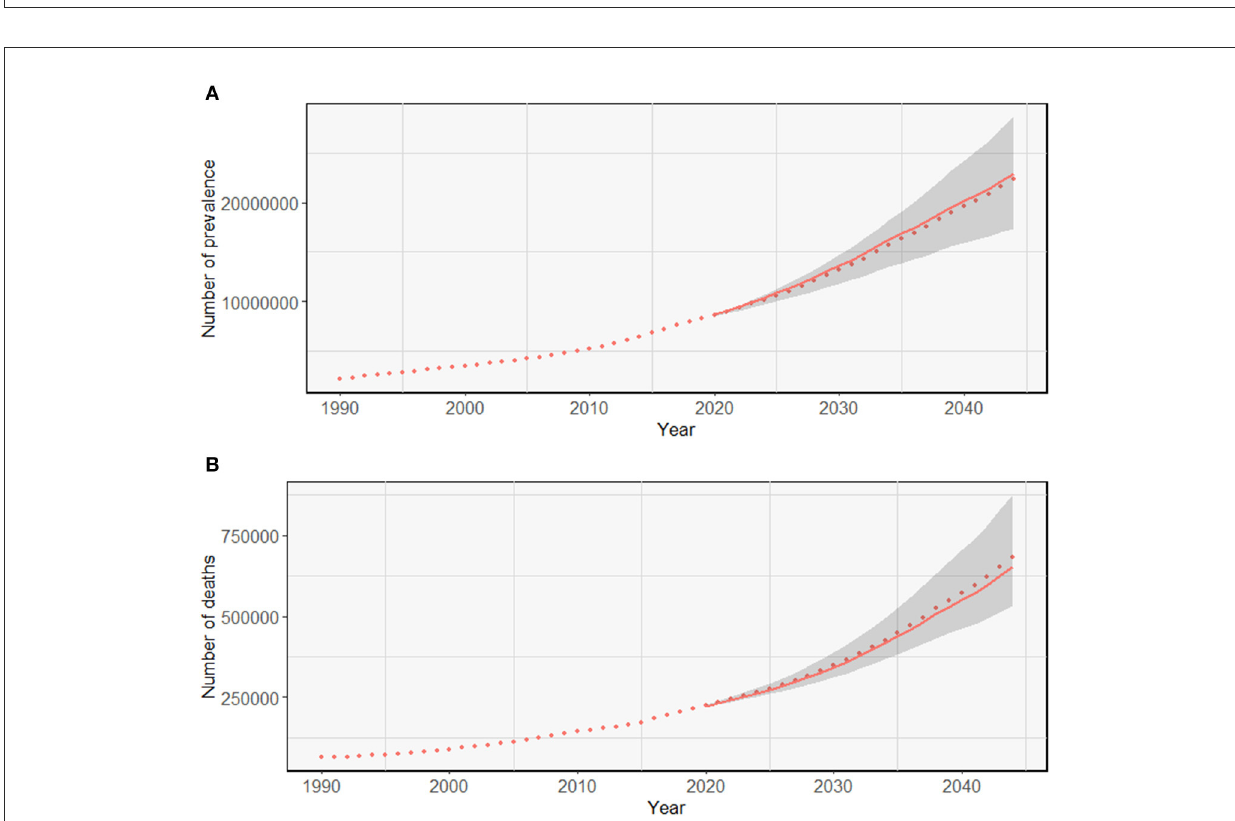
FIGURE5 Trends in the observed and predicted prevalence (A) and death rates (B) of Alzheimer’s disease and other dementias. The solid line shows the number of CFWD and deaths in the next 25 years. The dashed line represents the number of CFWD observed and the predicted number of CFWD with the same prevalence and deaths as in 2019. The shaded parts indicate the situation if the prevalence and mortality decrease or increase by 1% per year from those in